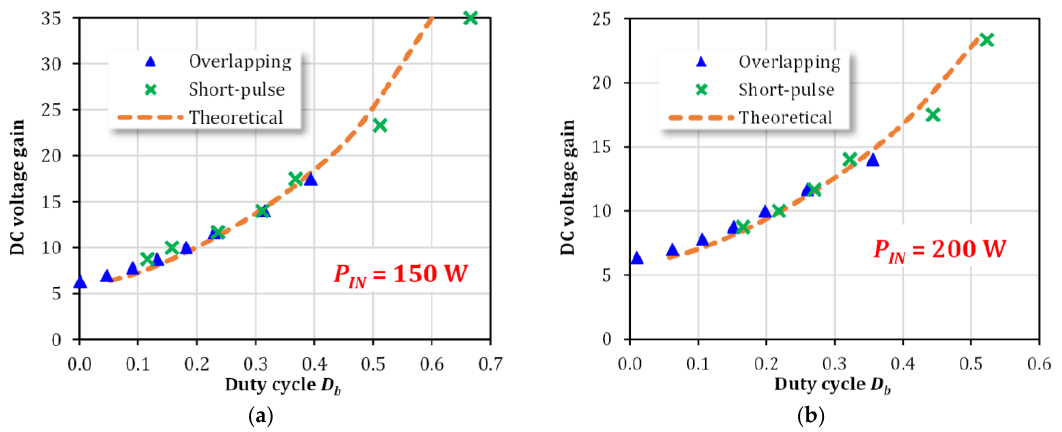
Figure 18. Comparison between the theoretical DC voltage gain and the experimental data at two input power values: ( a ) P IN = 150 W; ( b ) P IN = 200 W.